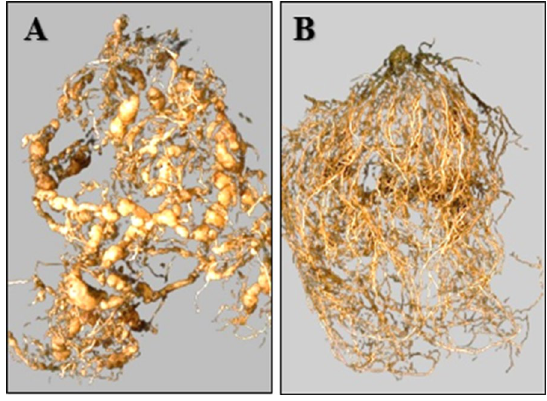
Fig. 4 Galled roots of A Control negative and B Best treatment ( Trichoderma harzianum)